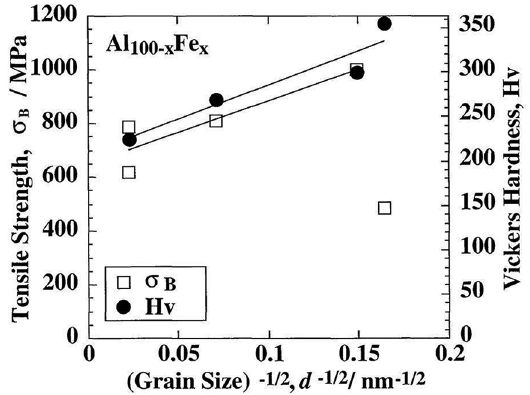
Figure 12. Grain size dependence of tensile strength and Vickers hardness of Al-Fe deposited alloy 52 .